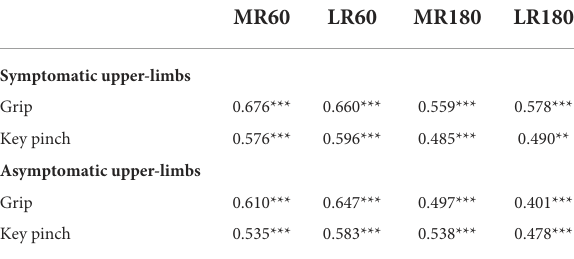
TABLE 2 Correlations between isometric hand strength and shoulder isokinetic strength on symptomatic upper-limbs in patients with thoracic outlet